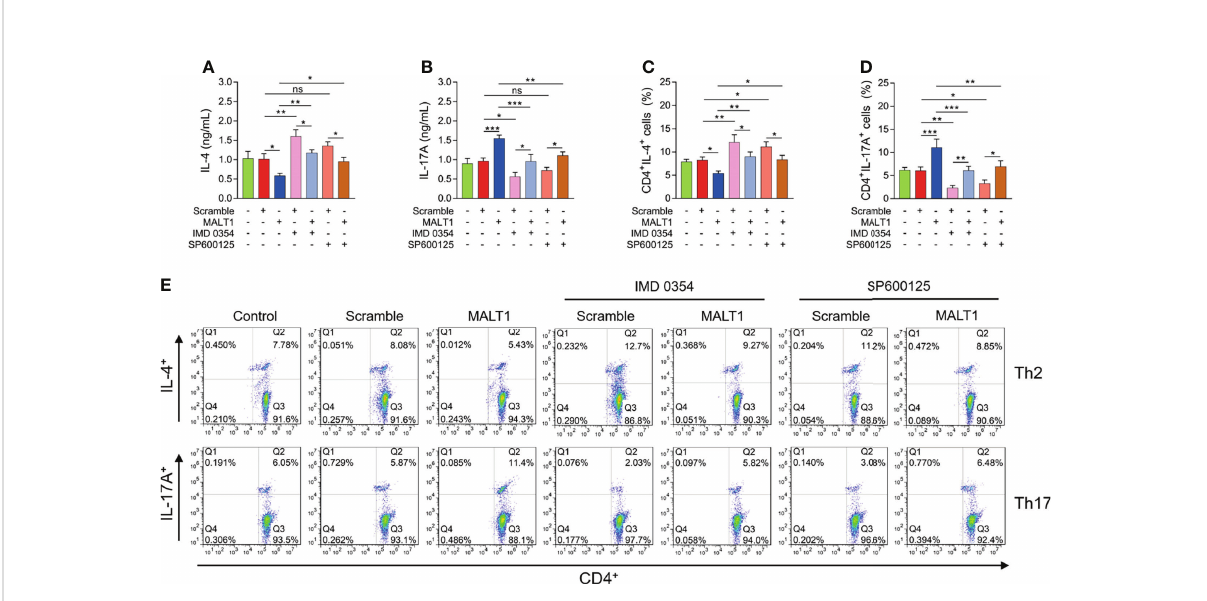
FIGURE 8 Effect of IMD 0354 and SP600125 treatment on Th1/2/17 cell differentiation in RA. IL-4 level (A) , IL-17A level (B) , CD4 + IL-4 + cells (C) , CD4 + IL- 17A + cells (D) after lentivirus transfection, IMD 0354 treatment, SP600125 treatment, alone or in combination. Examples of fl ow cytometry images after lentivirus transfection, IMD 0354 treatment, SP600125 treatment, alone or in combination (E) . * meant P<0.05, ** meant P<0.01, *** meant P<0.001. ns meant not signi fi